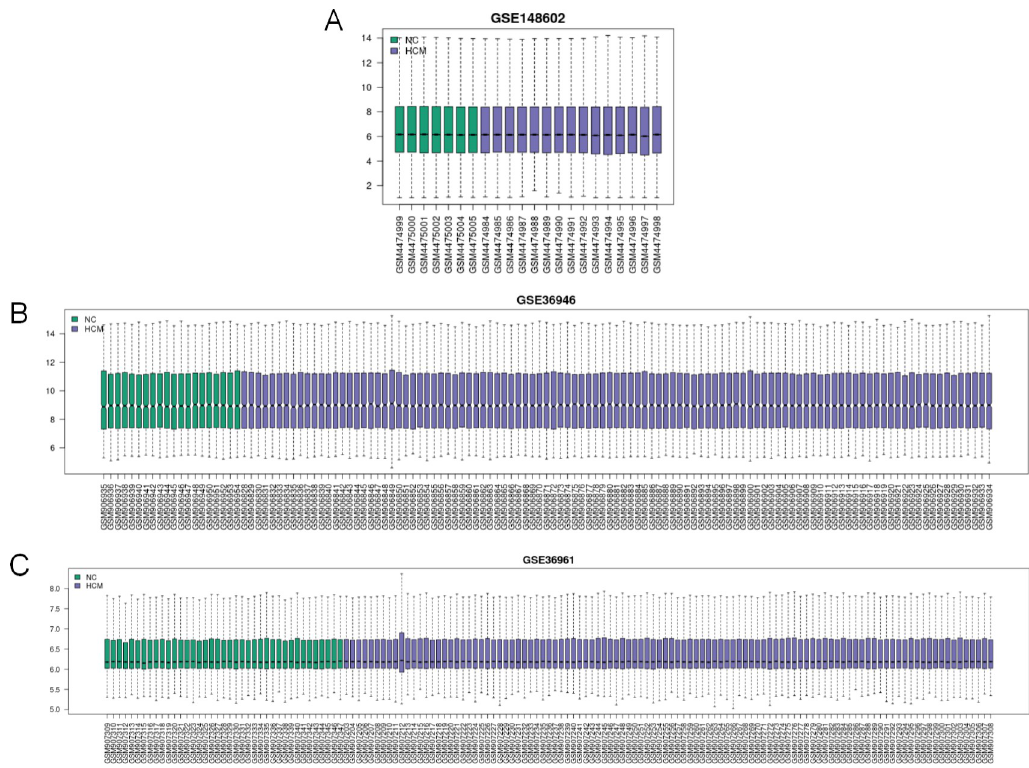
Fig 2. Quality control chart. A, GSE148602; B, GSE36946; C, GSE36961.